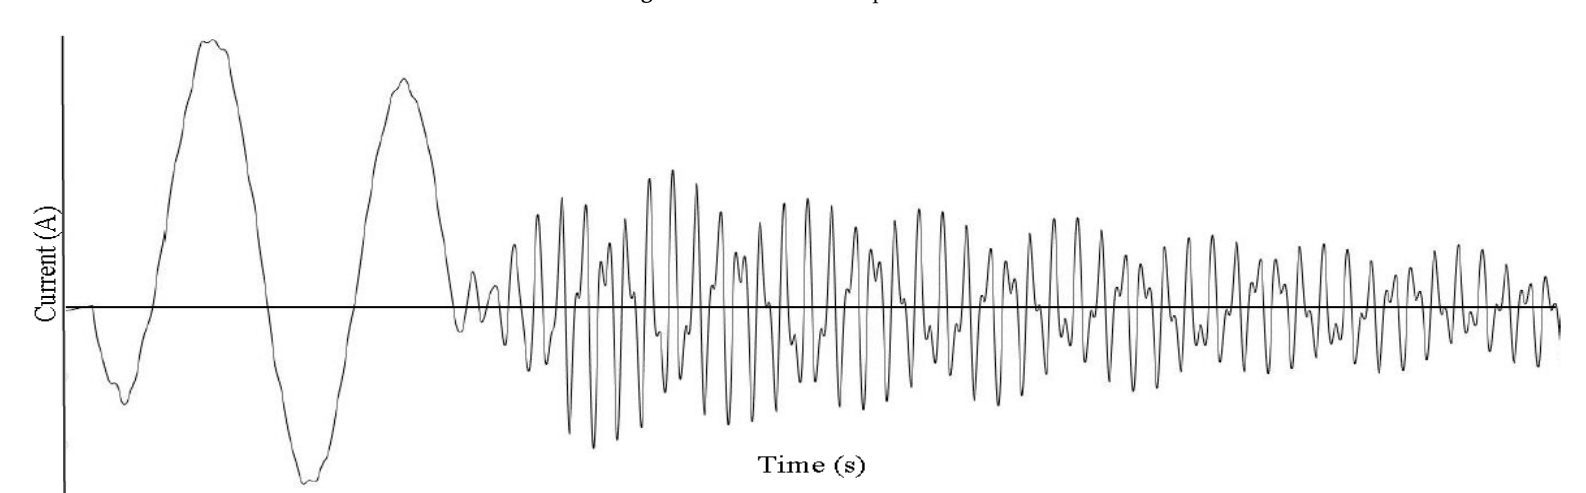
Figure 15. Bus capacitance increased by 20%.